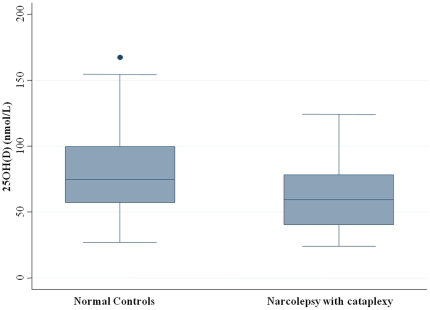
Sera measurement of 25-hydroxyvitamin D (25(OH)D) level (in nmol/L) in patients with narcolepsy-cataplexy and age- and gender-matched normal controls.Results are shown as a box-whisker plot, with median and 25th quartile of 25(OH)D. We noted significantly lower level in patients compared to controls (P = 0.0039).